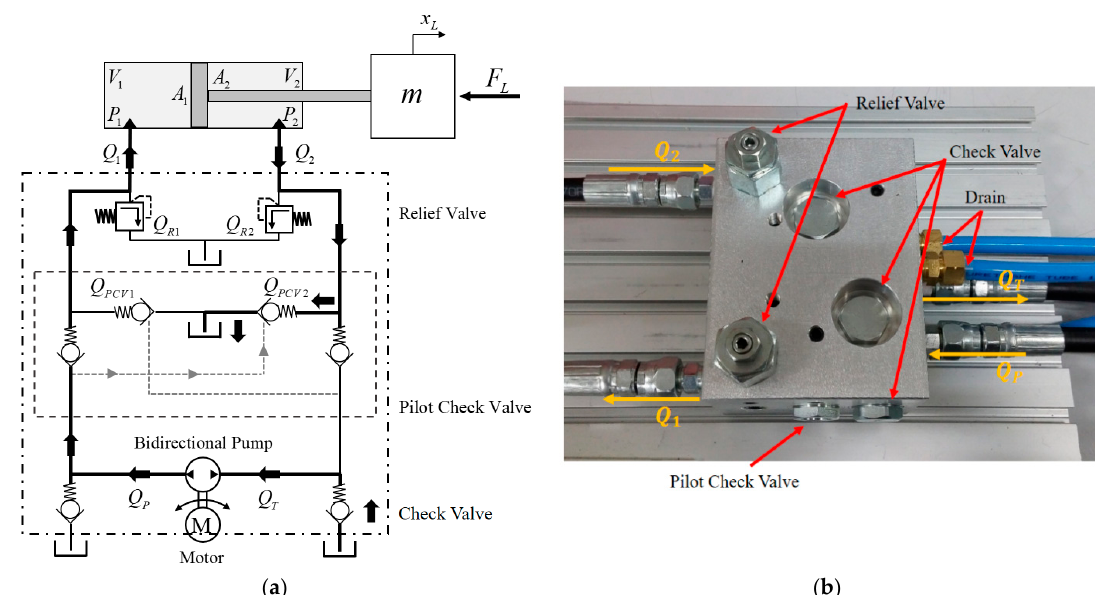
Figure 7. The hydraulic fluids circulate in the system: ( a ) is the proposed hydraulic circuit, and ( b ) is a manifold of the hydraulic circuit.